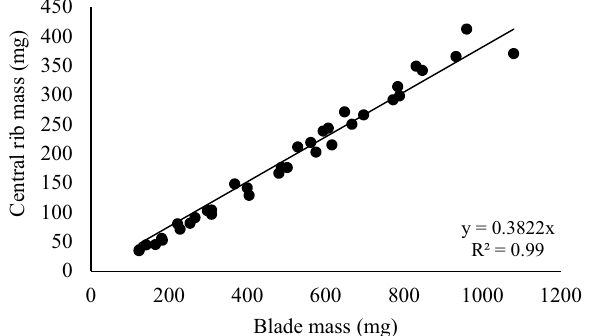
Figure 2. Relationship between whole leaf central rib mass (mg) and blade mass (mg) of Napier elephant grass leaves.